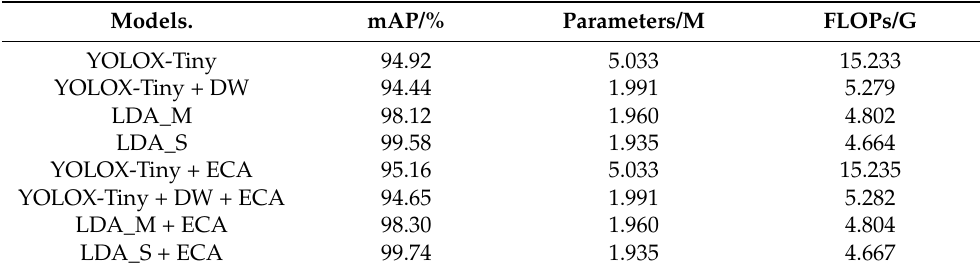
Table 6. Evaluation results of ablation